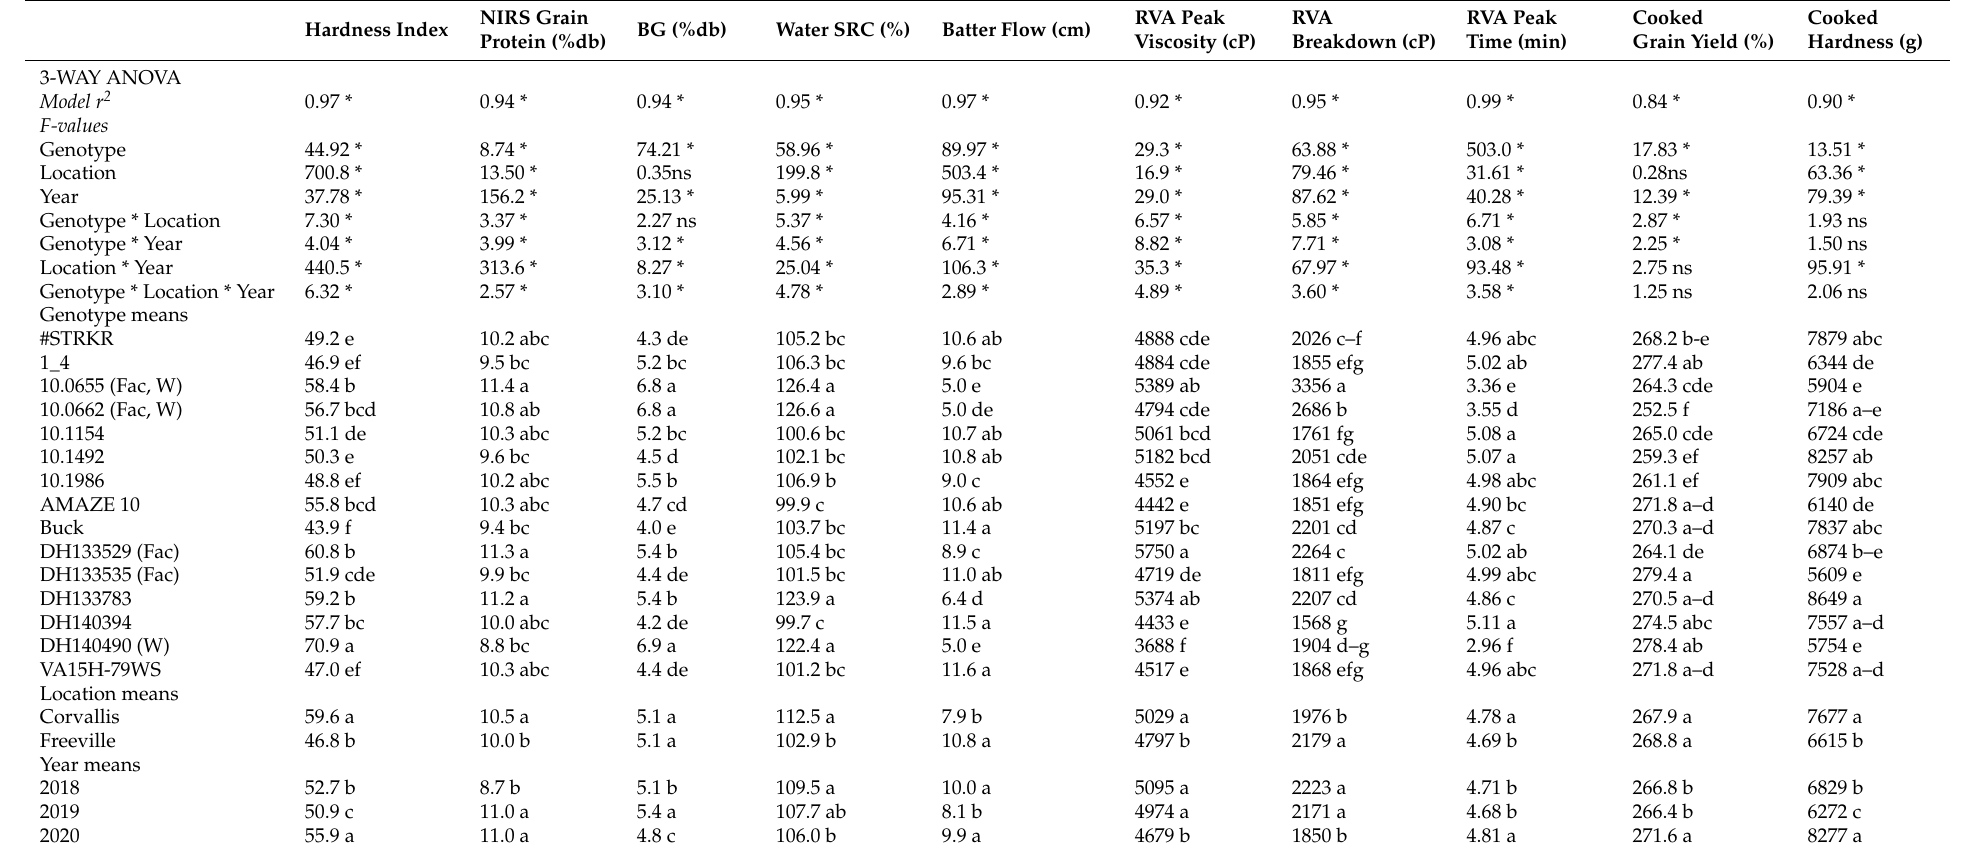
Table 3. Three-way ANOVA for food traits of winter